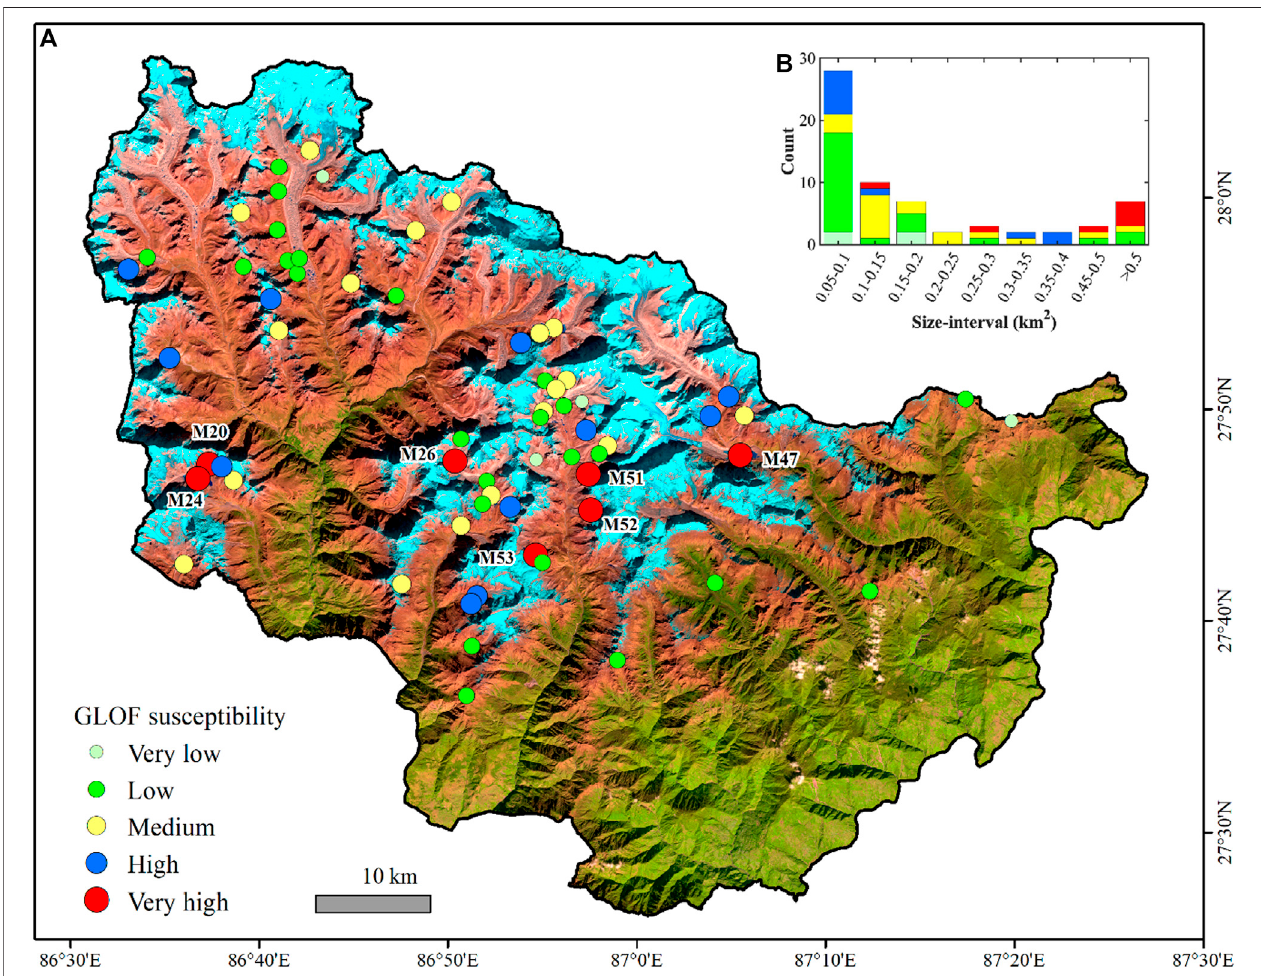
FIGURE 7 | (A) Map showing the spatial distribution of 64 glacial lakes assessed with their GLOF susceptibility classes across the Mahalangur Himalaya. (B) The bar graph shows the GLOF susceptibility of glacial lakes in various size interval. The background is false-colour composite Landsat OLI image acquired from November 19,